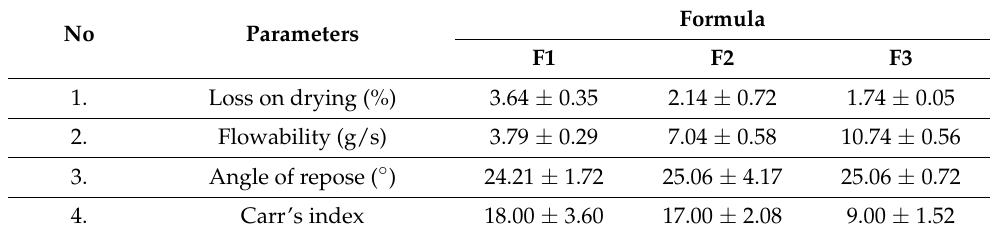
Table 6. Granule properties of the optimized